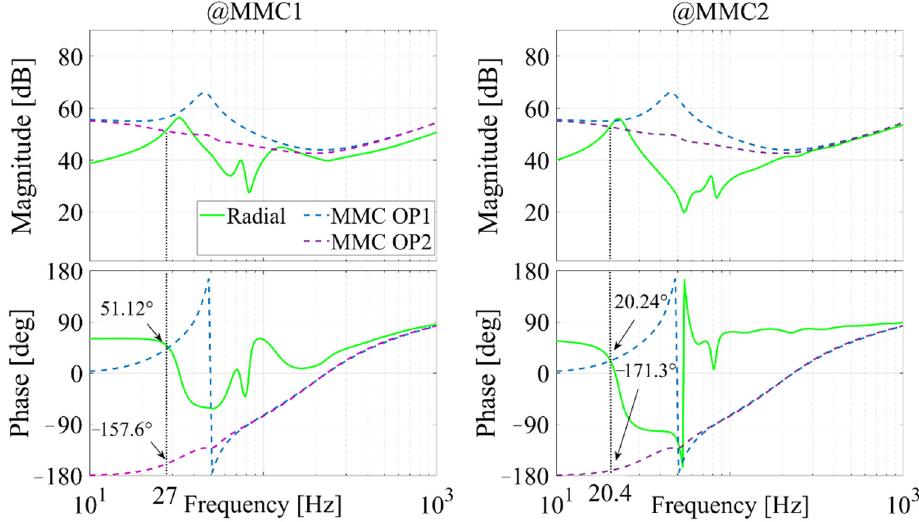
Figure 13. Impedance of MMC station 1&2 and network impedance seen from the terminals of MMC stations